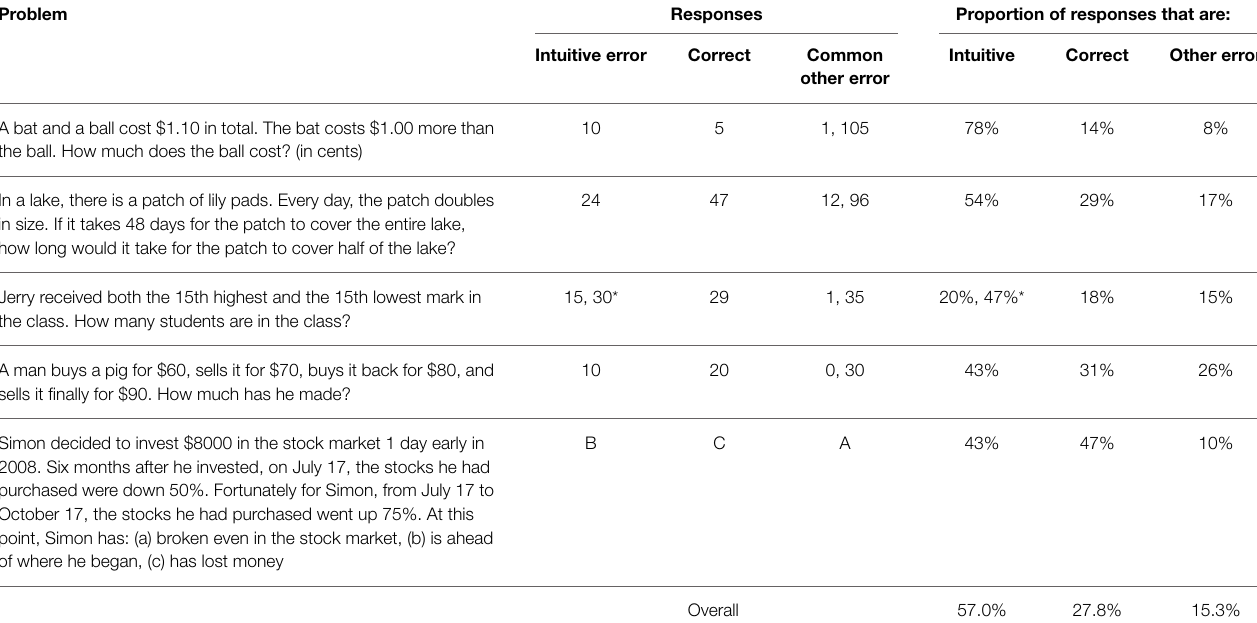
TABLE 2 | Intuitive and correct responses for CRT items used in Study 1. Problem